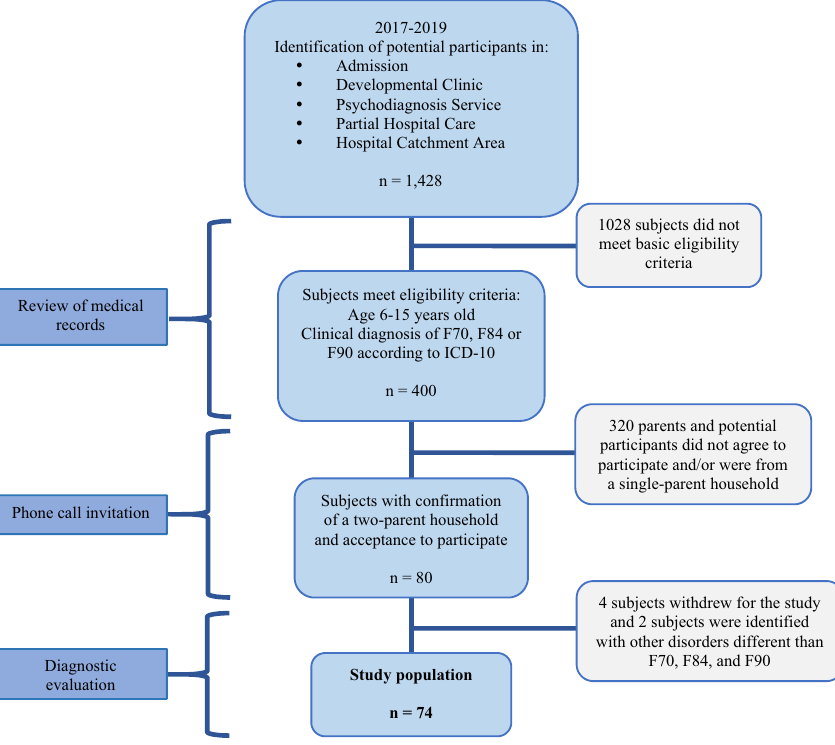
Figure 1. Identification of study population, children with and without neurodevelopmental disorders (F70-Mental Retardation, F84-Pervasive Developmental Disorders, F90-Hyperkinetic Disorder), Mexico City,